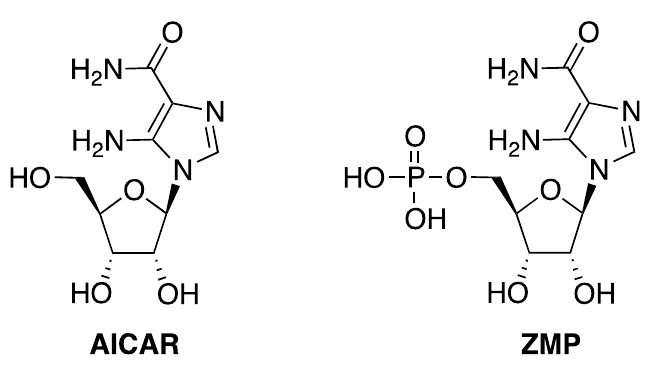
Figure 1. Structures of AICAR and